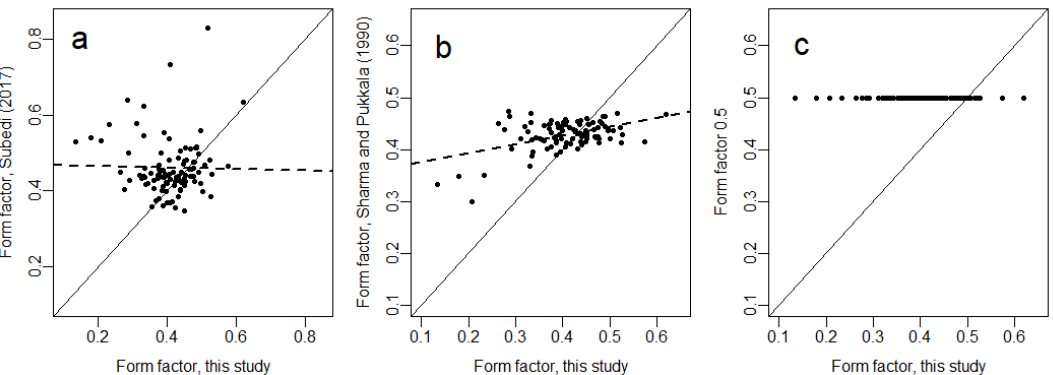
Figure 4. Evaluation of FFs derived by this study with other sources ( a ) FF based on volume functions by [19], ( b ) FF based on volume functions by [18] and ( c ) FF of